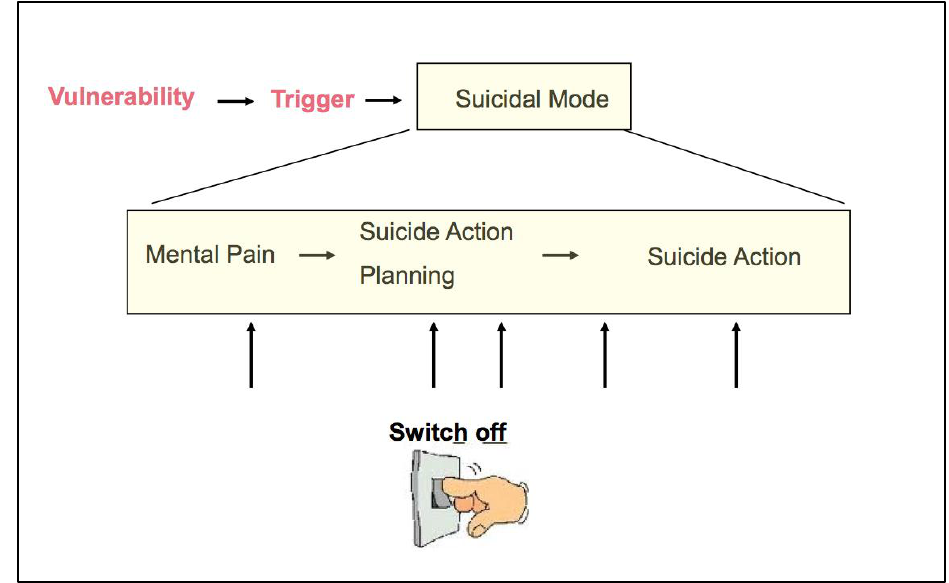
Figure 1. The treatment model of ASSIP, illustrating that safety strategies can switch off the suicidal mode at various stages in the development of the suicidal mode.